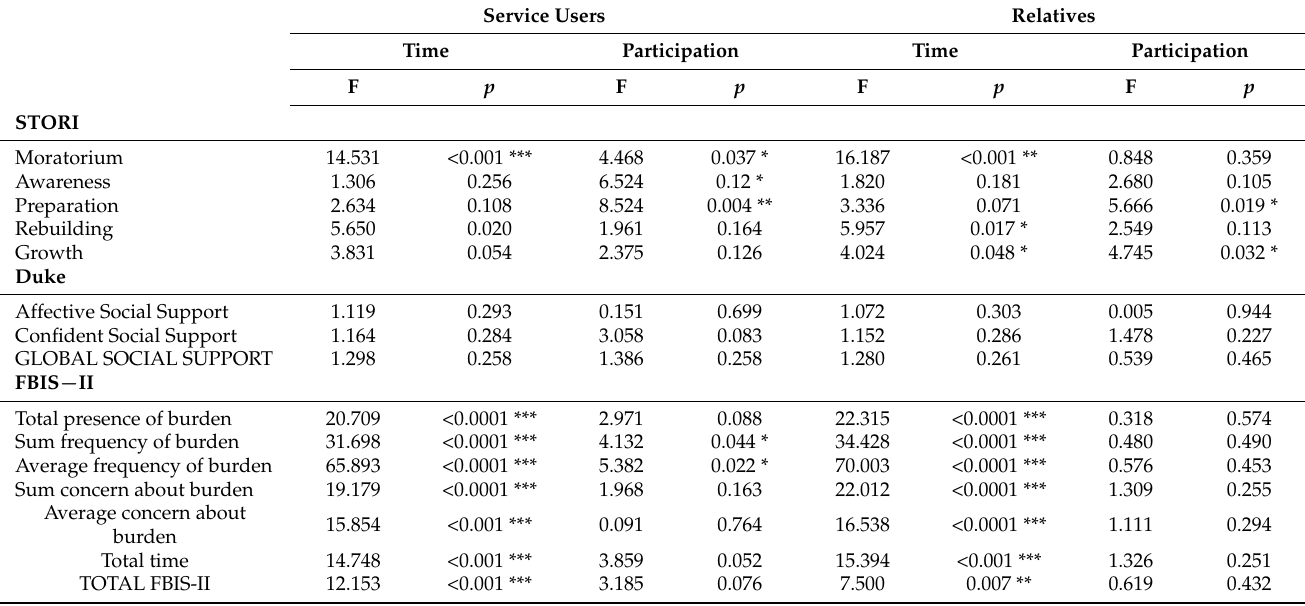
Table 5. Mixed models’ type III effects of time and